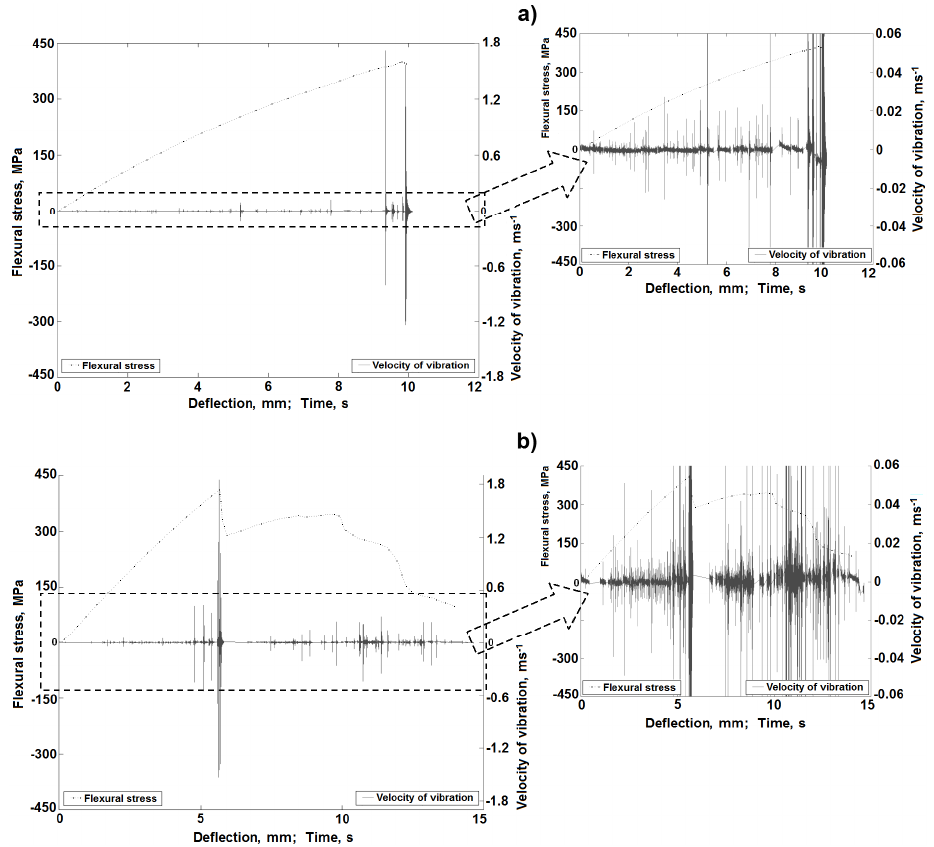
Figure 13. Characteristics of the vibration rate changes during a bending test for a 3D laminate sample: ( a ) Load direction along translaminar interweave strands ( W ); ( b ) Load direction perpendicular to translaminar interweave strands ( P ) [53].